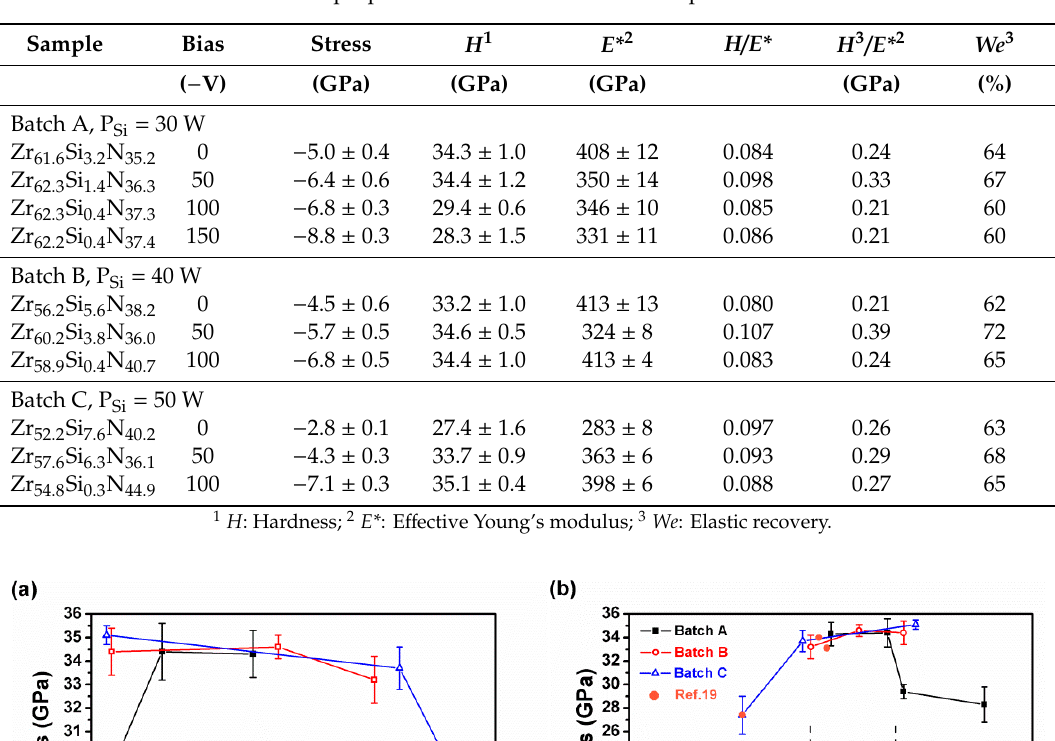
Table 2. Mechanical properties of the HiPIMS-RFMS-cosputtered Zr–Si–N films.